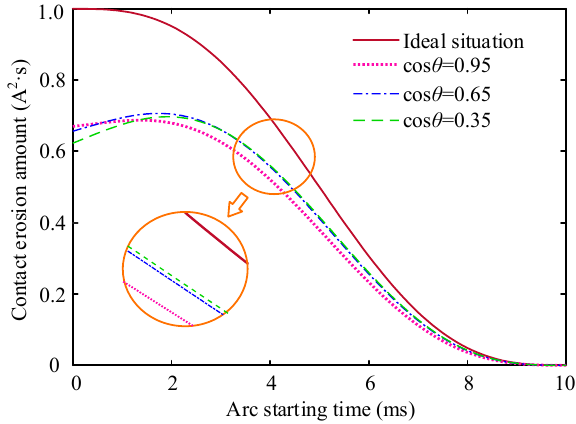
Figure 8. CEA curve of single operation with the AST.